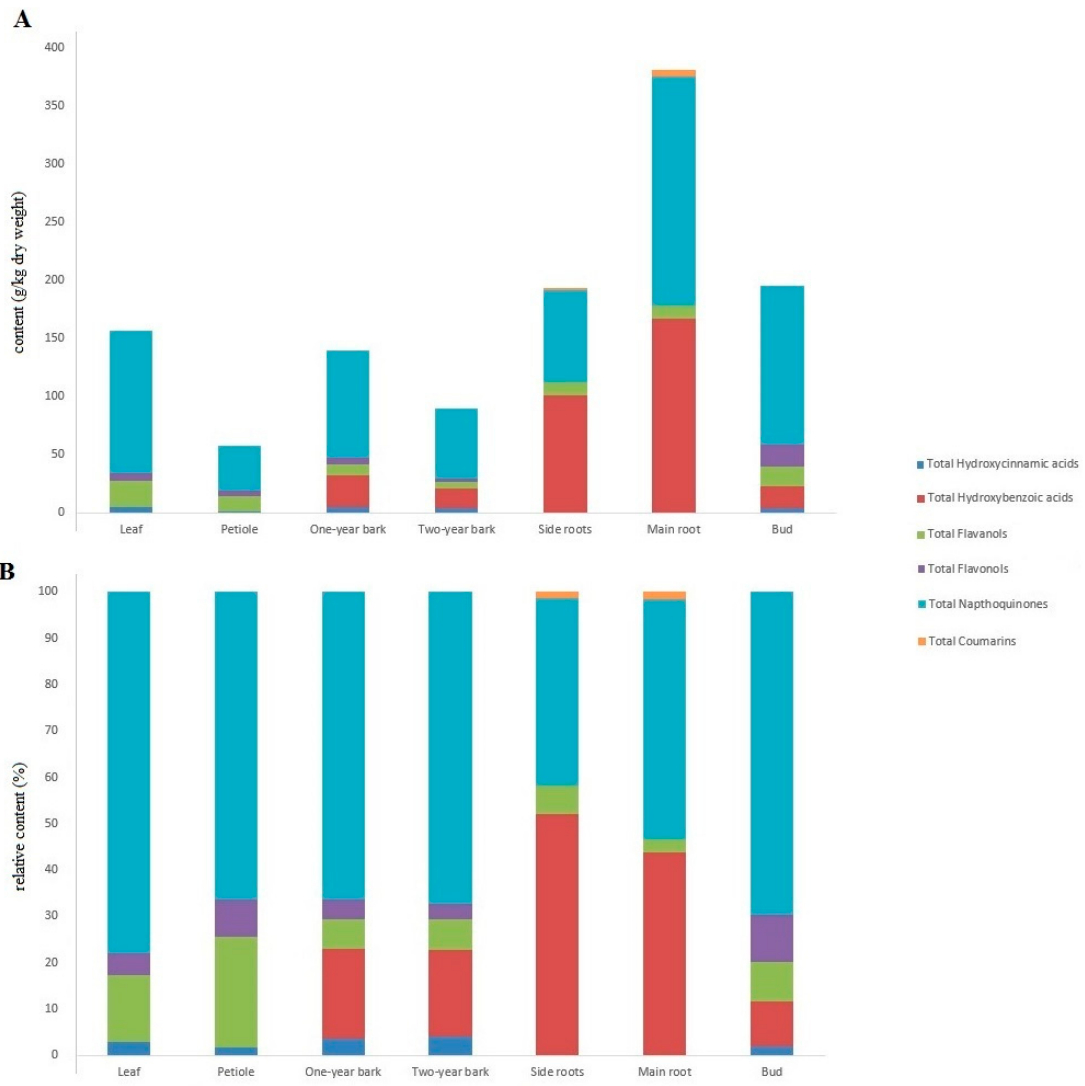
Figure 2. Content of the various phenolic groups identified in the different walnut tissues, as g/kg dry weight ( A ) and as relative contents as a proportion of the total phenolic compounds identified ( B ).